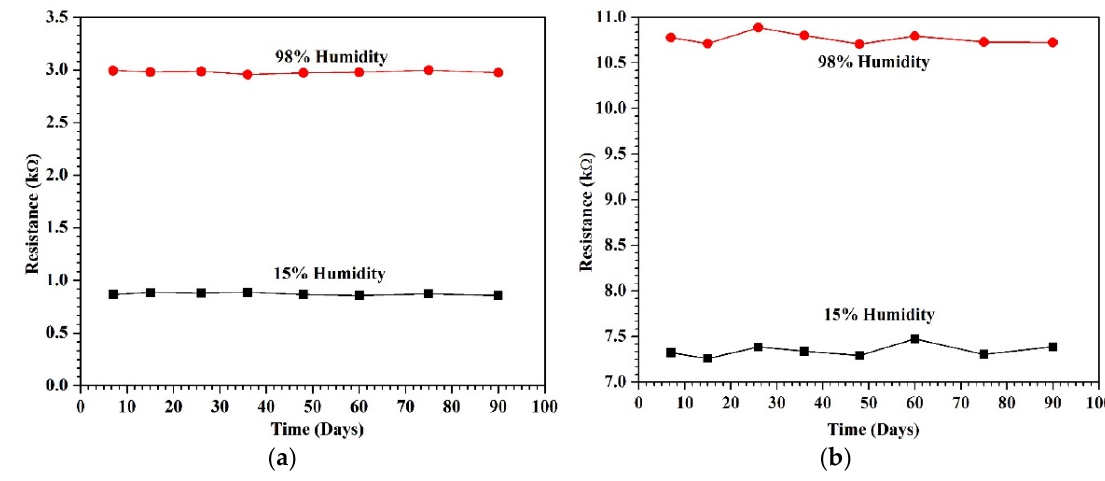
Figure 8. Long-term stability of ( a ) suspended sensors and ( b ) non-suspended sensors of 36 µm.